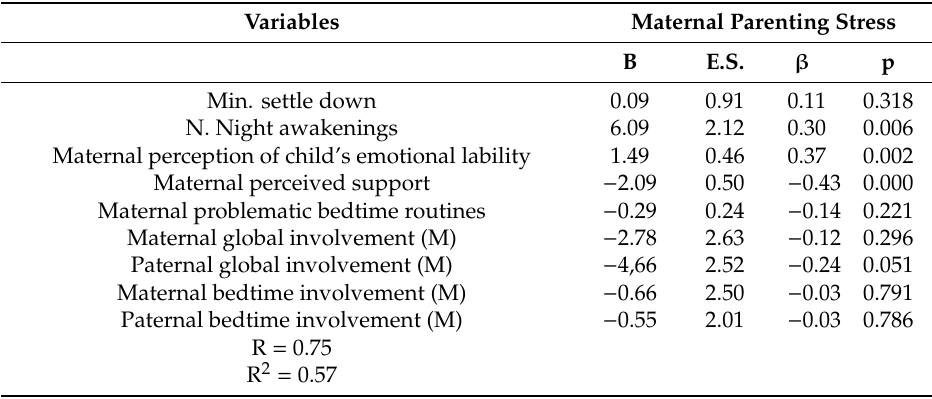
Table 3. Regression coe ffi cients of predictors of maternal parenting stress. Variables Maternal Parenting Stress